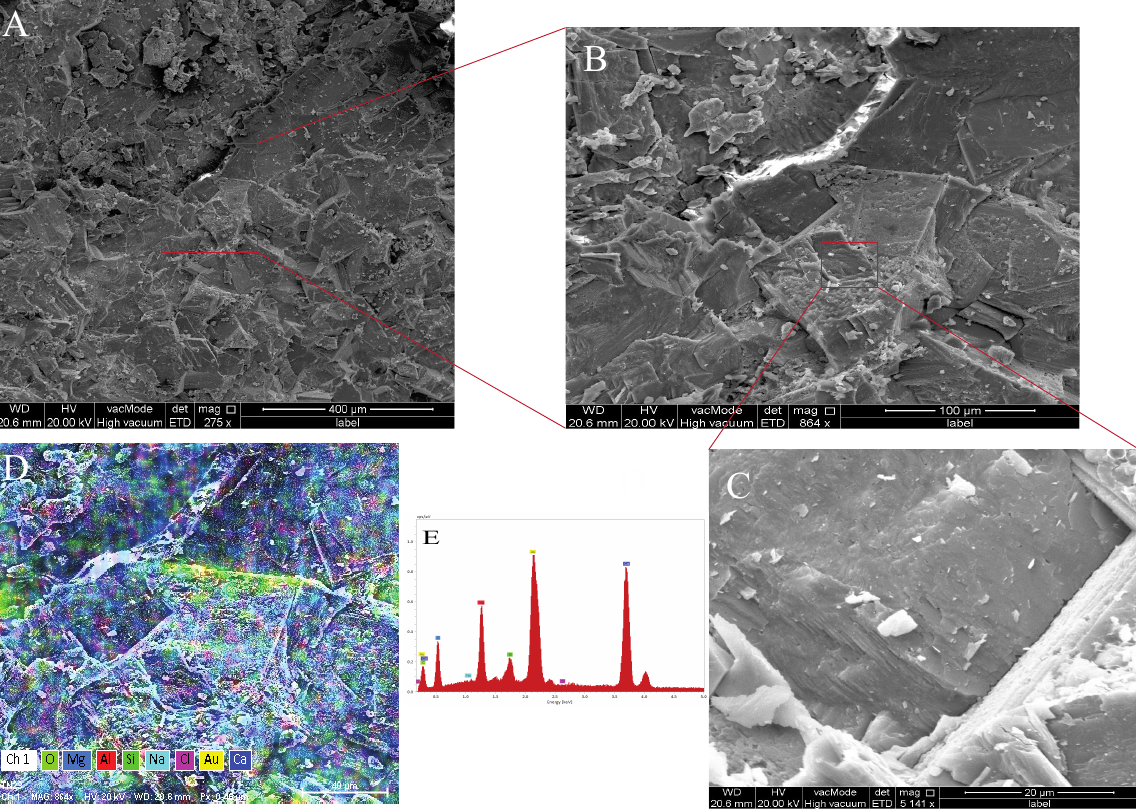
Figure 7. SEM/EDX images of the evaporite carbonate rock sample obtained from freshly gold coated surface, the images illustrate: ( A ) the carbonate grains cemented by evaporitic minerals, the circle marks the aggregate grains of gypsum crystals, the rectangle marks two phases of minerals and this part, enlarged in ( B , C ), where the central part, composed of euhedral, eroded the surfaces of calcite crystals where cemented by evaporites. ( D , E ) Mineralogical mapping of the same sample location ( C ); ( D , E ) the majority of sodium element was distributed around the euhedral crystals of calcite.